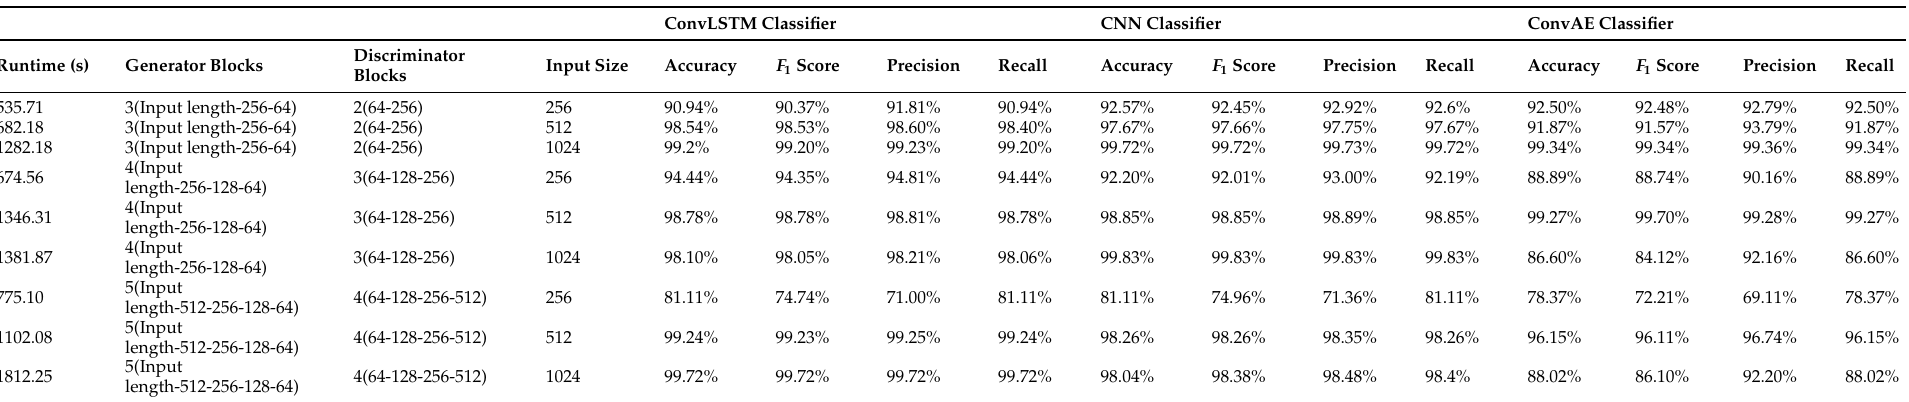
Table 4. Comparison between different architectures of the N2FGAN tested for 1772